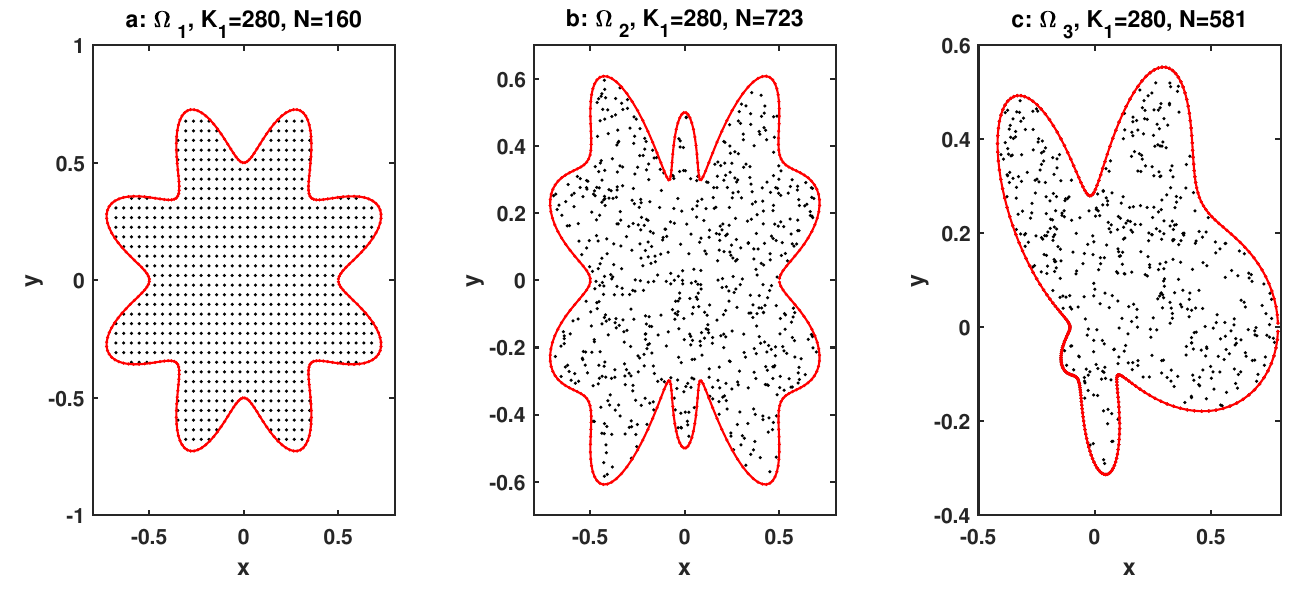
Figure 1. Irregular domain for Examples 2 and